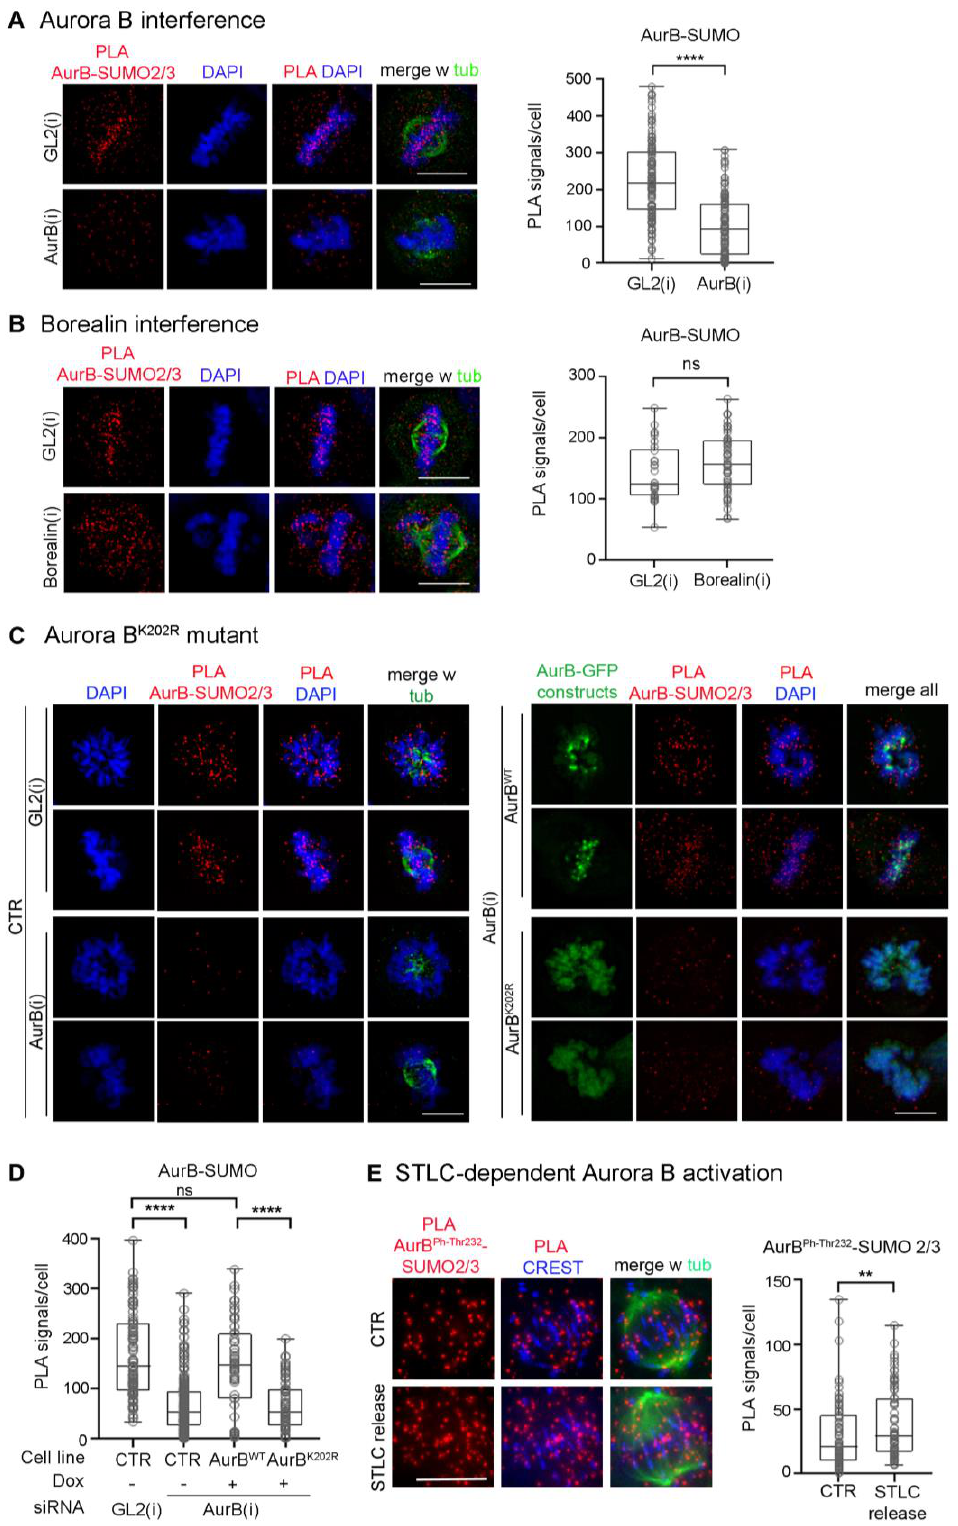
Figure 1. Aurora B-SUMO2/3 ligation products in prometaphase and metaphase HeLa cells. ( A ) Aurora B-SUMO2/3 PLA signals disappear in cells interfered for Aurora B, indicated as AurB(i). Control cultures were treated for RNA interference with neutral siRNAs targeting the firefly luciferase, indicated as GL2(i). The box plot represents the distribution of PLA signals in prometaphase and metaphase in control vs. Aurora B-interfered cultures (140 counted cells/group in 3